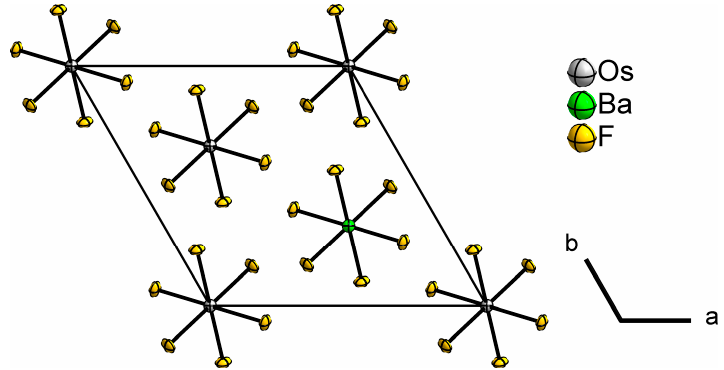
Figure 7. The crystal structure of BaOsF 6 (projection along c -axis). Displacement ellipsoids are shown at 70% probability level at 100 K.